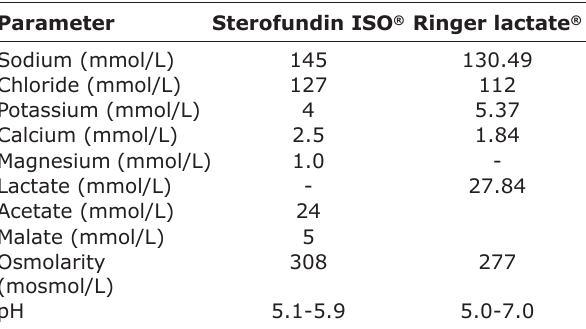
Table-1: Electrolyte composition of the rehydration solution used in 90 dehydrated